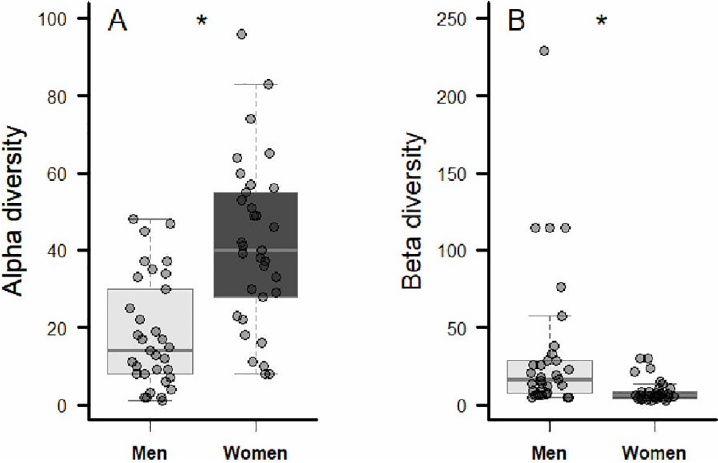
Fig 3. Comparisons between genders of alpha ( α ) and beta ( β ) diversity of known useful plants in an urban community in Ouro Preto, southeastern Brazil.